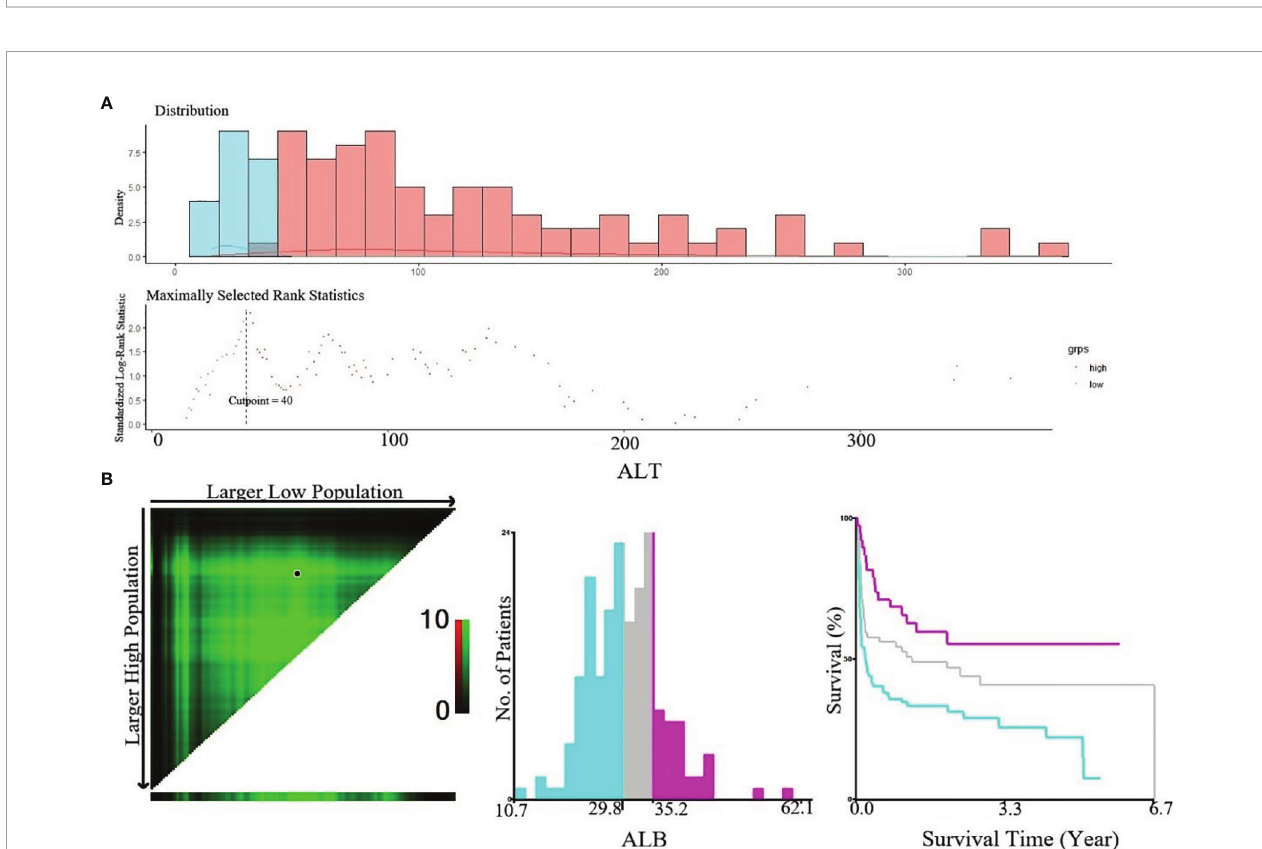
FIGURE 4 | (A) Cut-off point of ALT de fi ned by using maximally selected log-rank statistics. The estimated optimal cut-off point of ALT was 40 U/L; (B) X-Tile analysis of OS according to Alb. The black circles highlighted the optimal cut-off values which were presented in histograms.